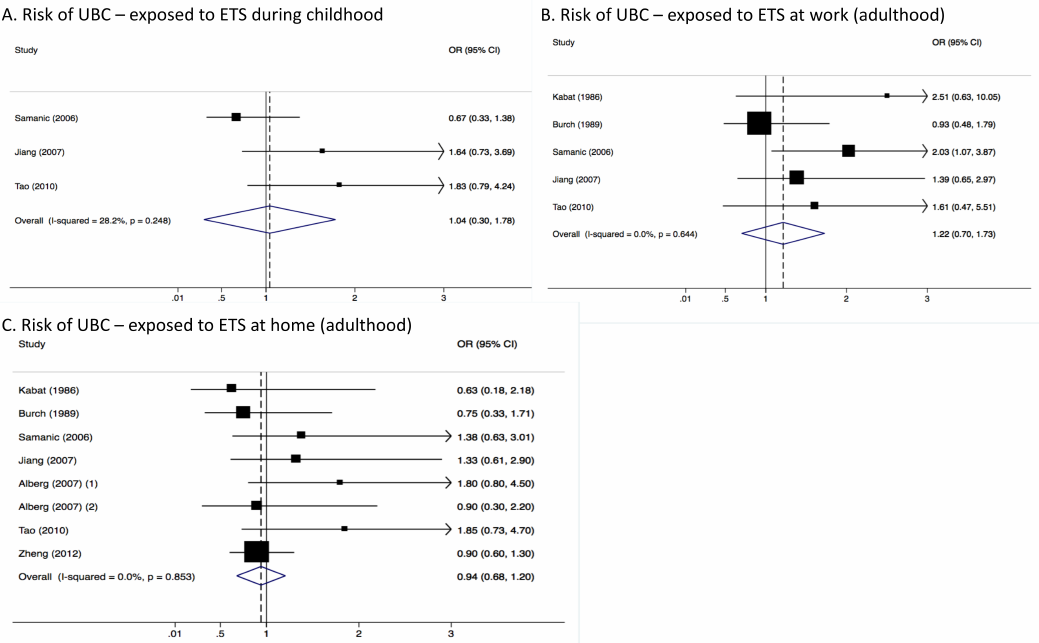
Figure 3. Meta-analysis results showing pooled risk estimates for urothelial bladder cancer (UBC) stratified by timing (childhood or adulthood) and location (work-related or domestic) of exposure to ETS for females